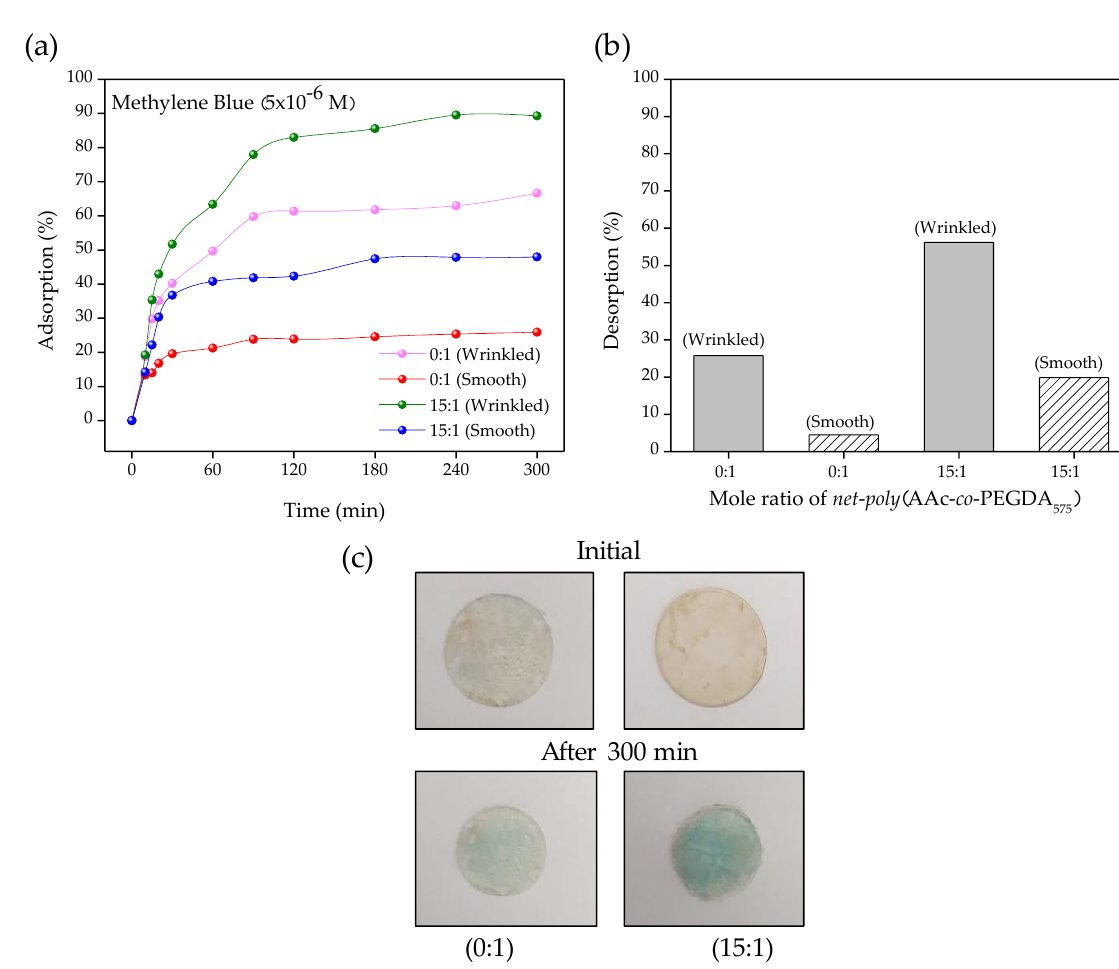
Figure 9. ( a ) MB adsorption percentage, ( b ) MB desorption percentage from smooth and wrinkled hydrogels with a concentration of 0:1 and 15:1, and ( c ) photographs of glasses with different hydrogel concentrations before and after MB adsorption.